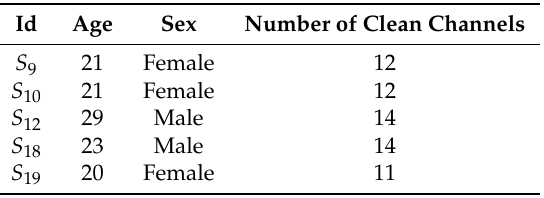
Table 1. Participants’ data.